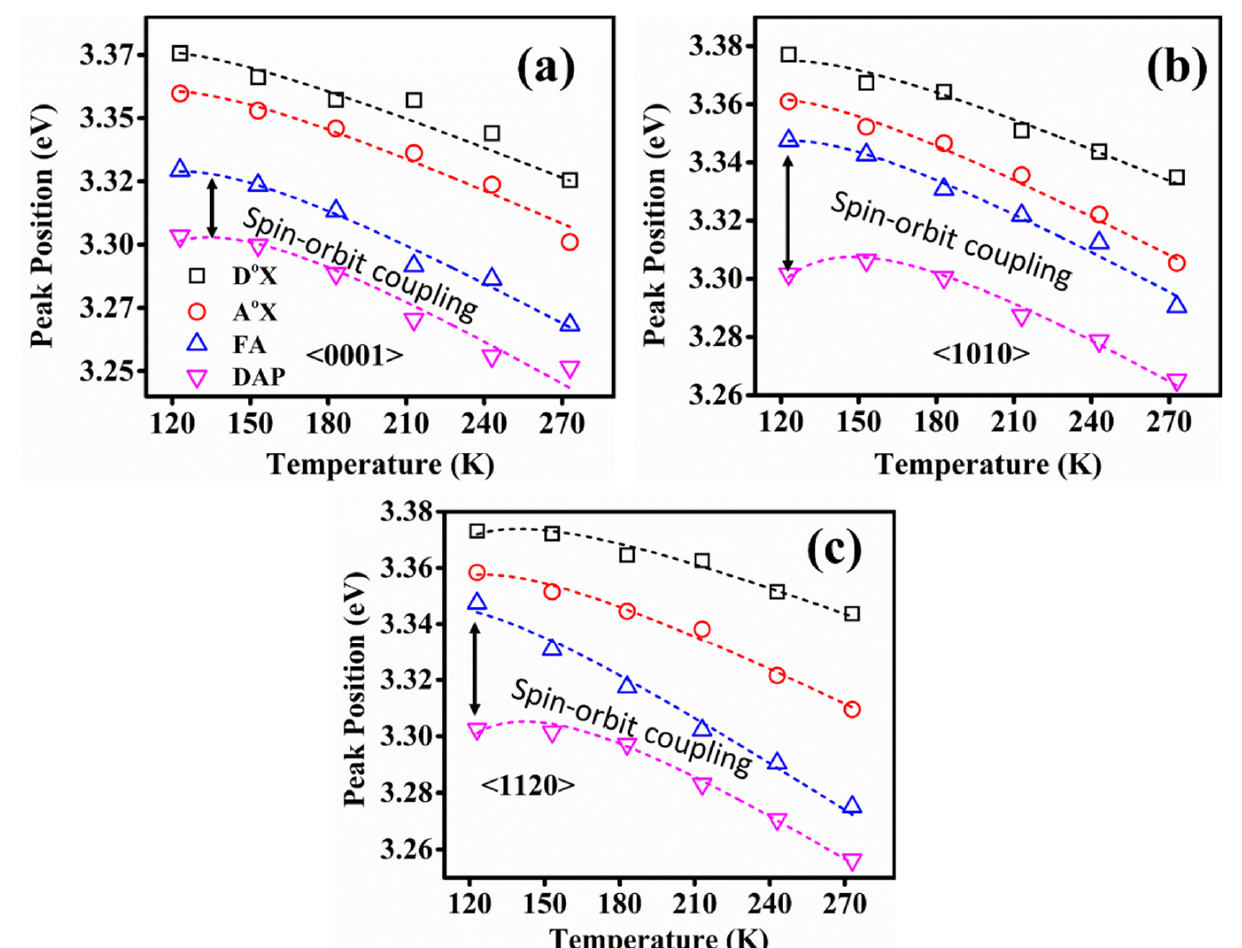
Figure 9. Temperature-dependent variation of peak positions for D o X, A o X, FA, and DAP transitions of ( a ) <0001> ( b ) <1120> and ( c ) <1010> orientations, respectively. Symbols indicate the experimen- tally observed peak positions of each transition and dashed lines are the fitting of experimental values with Varshni’s empirical formula.